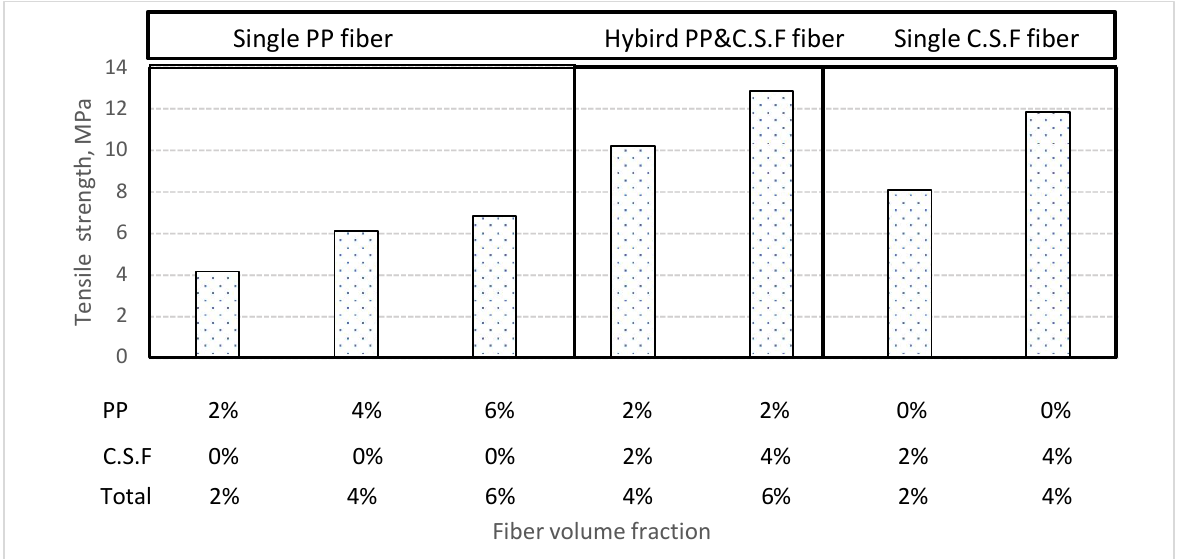
Figure 16. Effect of lightweight with heavyweight fiber hybridization on 28-day concrete tensile strength.